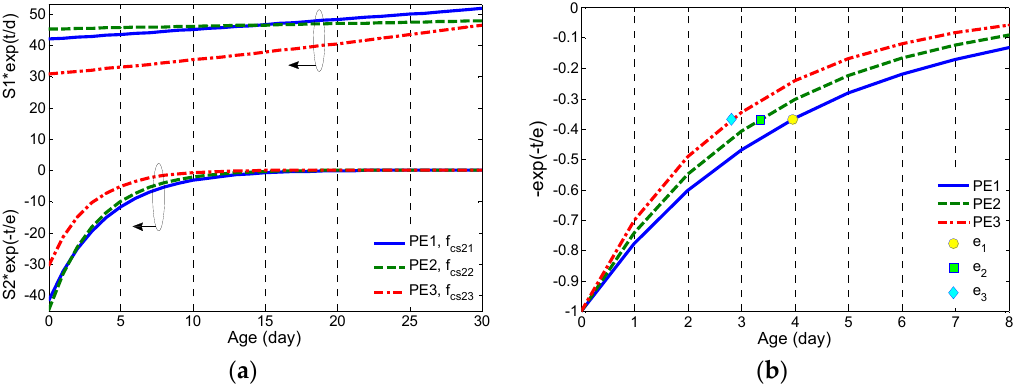
Figure 10. ( a ) Decomposition of bi ‐ exponential regression for all specimens; ( b ) step response of second term of (5) that shows the differences in time constant.